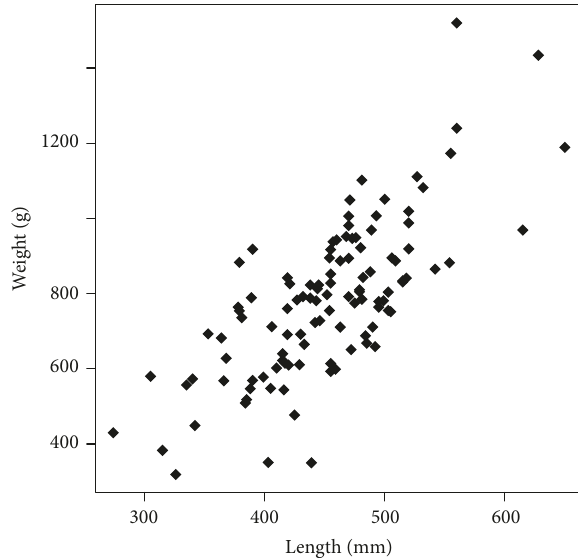
Figure 10: Measured and predicted weight by using proposed Bayesian method with M-RM prediction model. The proposed Bayesian method successfully predicted not only the whole shape of yams (Figures 8 and 9) but also the weight of the yams.